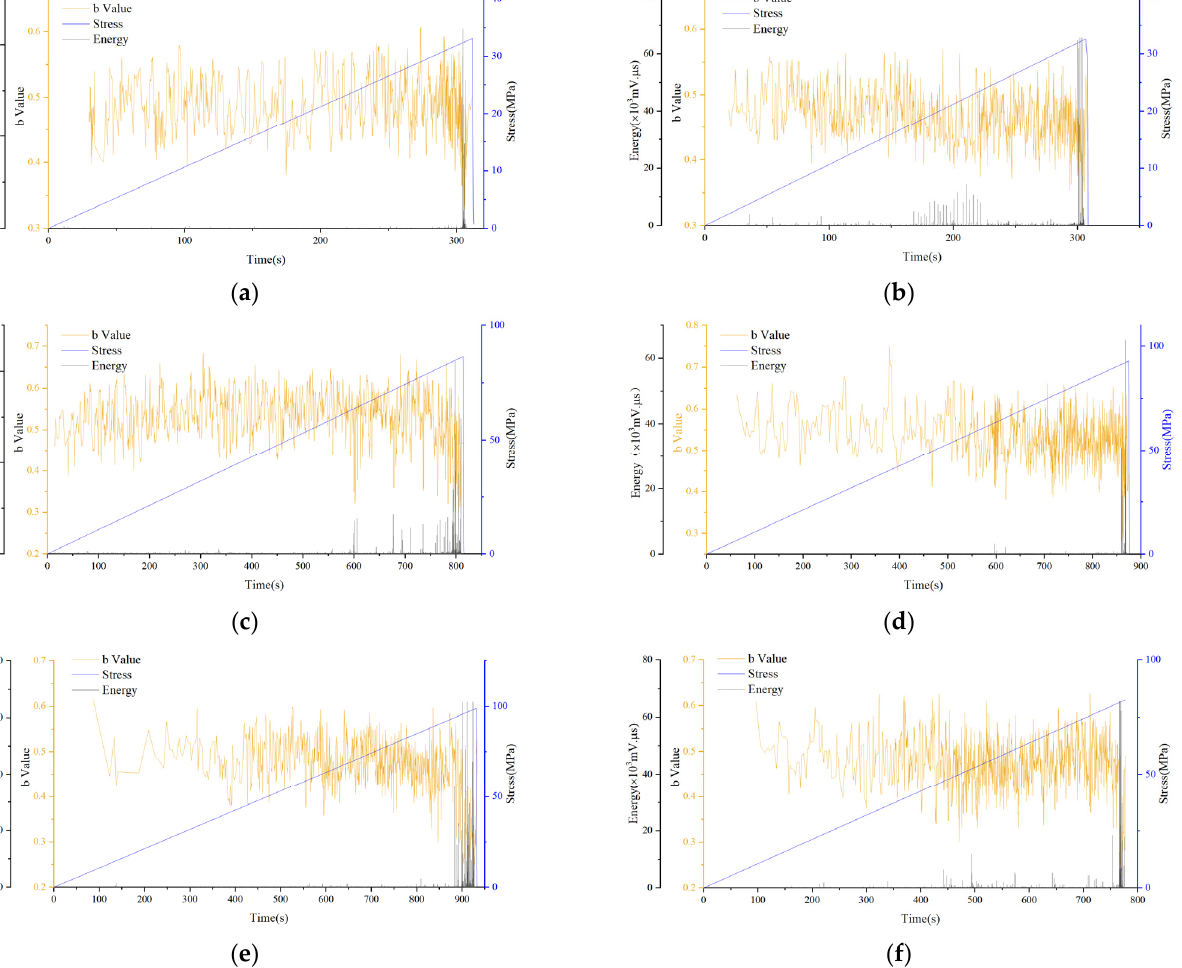
Figure 11. Variations in the b values of the tested specimens: ( a ) URC-0, ( b ) URC-5, ( c ) CRC-5, ( d ) JRC-0, ( e ) JRC-5, ( f ) JRC-10. ( d ) JRC-0, ( e ) JRC-5, ( f )